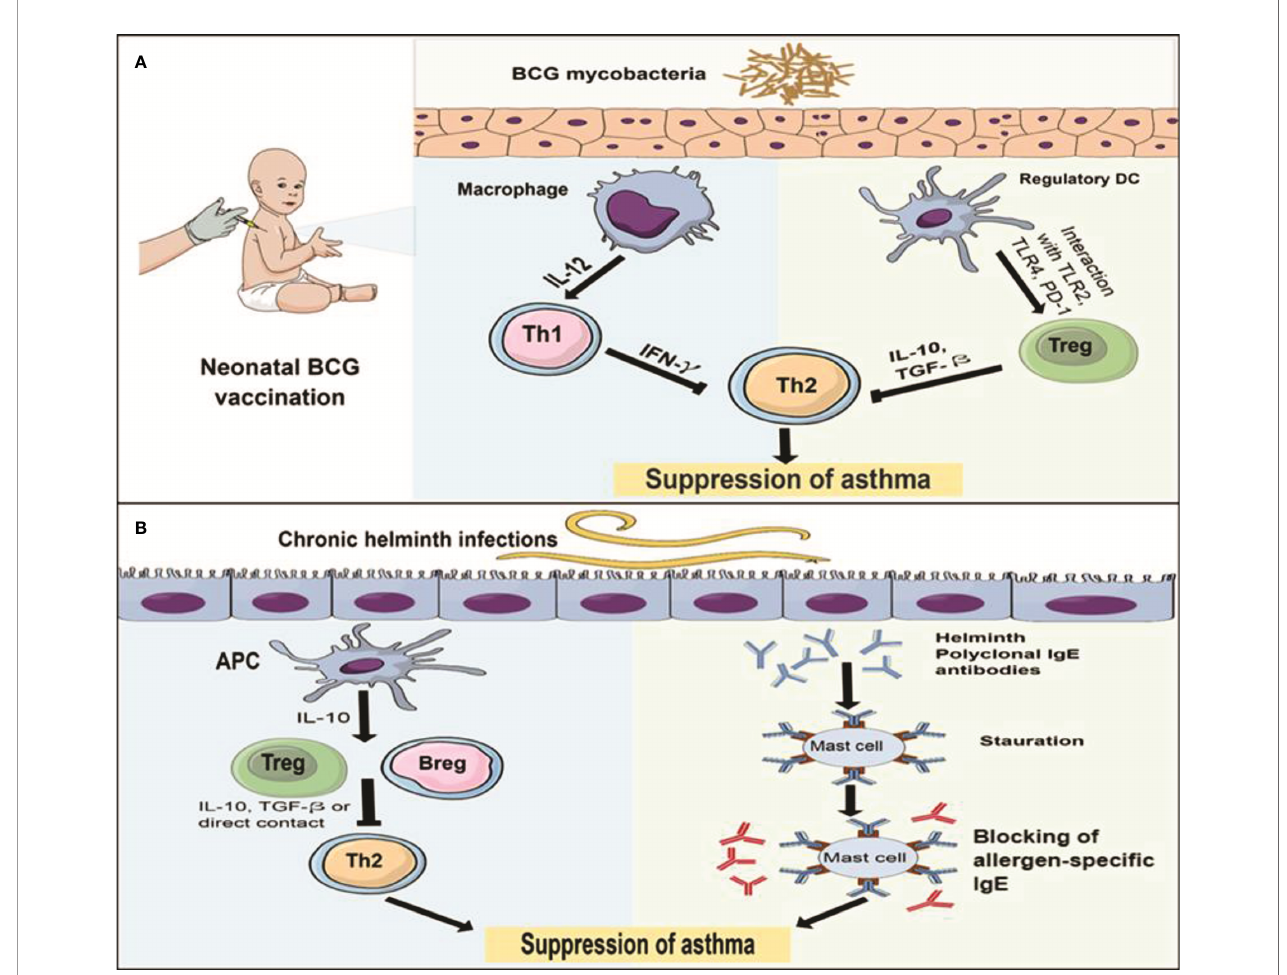
FIGURE 1 | The immune mechanisms of BCG and helminths protect against allergic asthma (A) The protective effect of neonatal BCG is mediated through two pathways: the fi rst pathway (left) is induction of Th1 cells polarization by IL-12 secreting macrophages, the resultant IFN- g inhibits Th2 response with subsequent suppression of asthma. Another pathway (right) is the upregulation of Tregs polarization through interaction with TLR2, TLR4 and PD-1 expressed on DCs, the resultant IL-10 and TGF- b reduce TH2 response and suppress asthma. (B) The protective effect of chronic helminth infection is mediated through 2 pathways: the fi rst pathway (left) is the induction of T and Bregs differentiation by IL-10 secreting antigen presenting cells (APCs). Then, Th2 response is inhabited by IL-10 and TGF- b or the direct contact between Tregs and Th2 cells, which leads to suppressing asthma. The second pathway (right) is the saturation hypothesis in which helminth infections induce polyclonal IgE (blue) that binds to and saturate high af fi nity Fc ϵ R on mast cells, preventing binding of allergen-speci fi c IgE (red) and subsequent blocking of mast cell